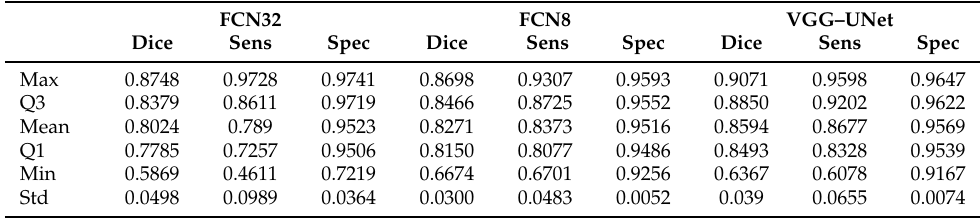
Table 3. Performance measures of FCN32, FCN8 and